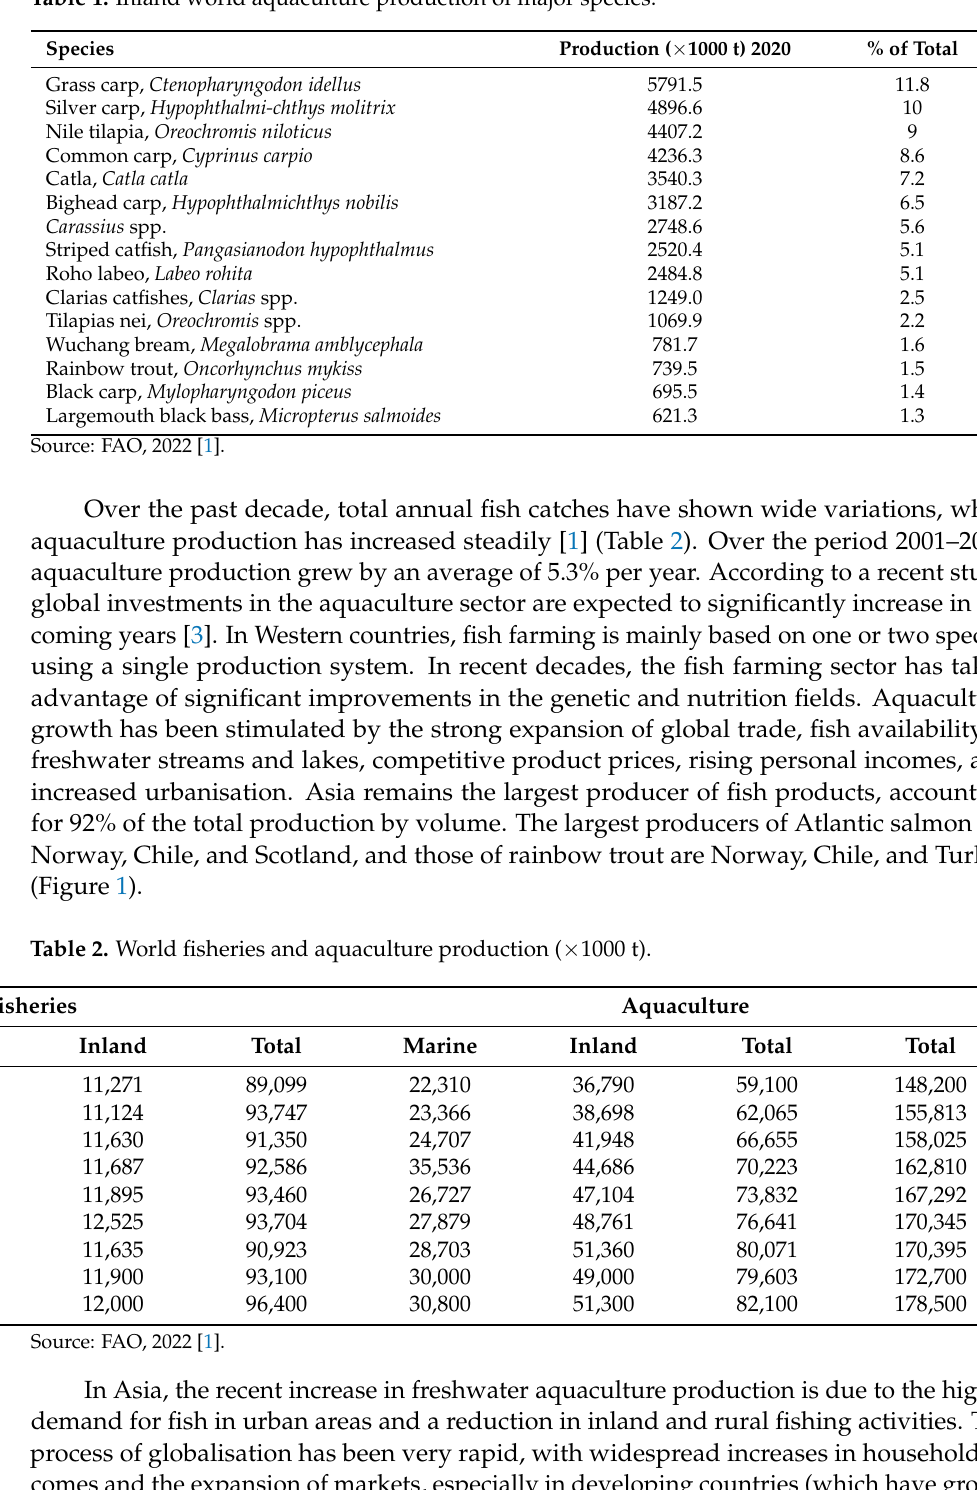
Table 1. Inland world aquaculture production of major species.